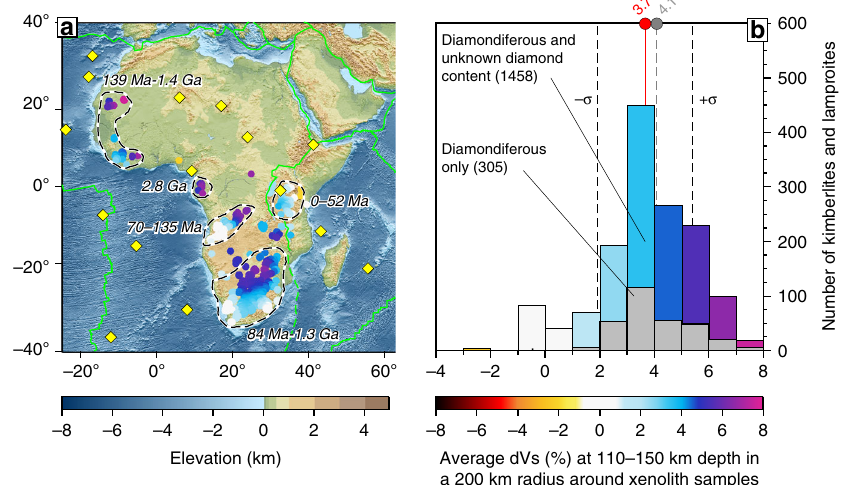
Fig. 3 Seismic velocity in the lithosphere beneath kimberlites and lamproites. The emplacement age ranges from 65 are indicated on the map for the different areas (dashed lines). Values of the average δ V S over the 110 – 150 km depth range and within a 200-km-radius circle around each Kimberlite sample are plotted on the map ( a ) and as a histogram ( b ). δ V S colour scale is as in Fig. 1c. The circle sizes show the lateral averaging area. Average δ V S across all diamondiferous and unknown-diamond-content kimberlites and lamproites is shown with a red line and dot ( b ), with the standard deviation also shown. Average δ V S for diamondiferous samples only is shown with a grey line and dot. Both groups present the same pattern: most are not on thick cratonic lithosphere at present. Elevation and bathymetry are plotted on panel a ; plate boundaries are plotted in green.